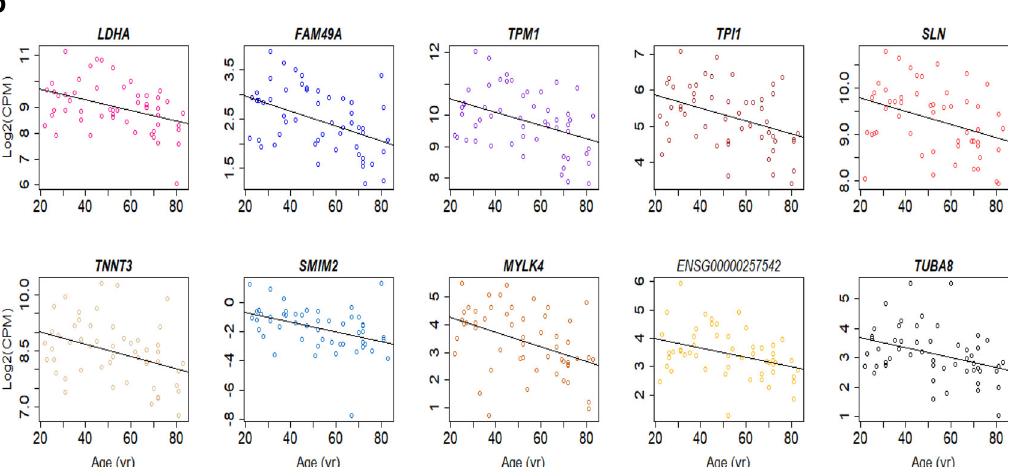
Fig. 3 Top 20 signi fi cant ( p < 0.01) RNAs (ENSGs) identi fi ed by linear regression with negative β - values for age. a Linear model p -values (two-sided Wald test, unadjusted) and β - values, and RNA characteristics obtained from literature review, are shown. RNAs that failed to have at least ten samples with CPM values above − 3 were removed. b Linear plots representing log2(CPM) values with age for the top ten RNAs ranked by the lowest p -value (two- sided Wald test, unadjusted) 97 – 108